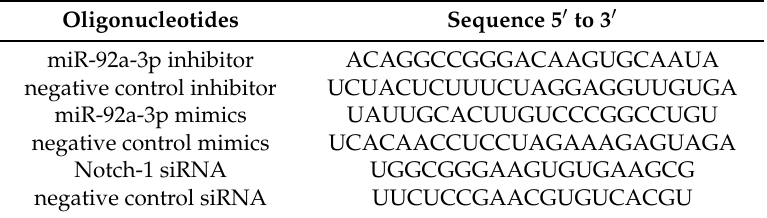
Table 1. Sequence of oligonucleotides used in this study.